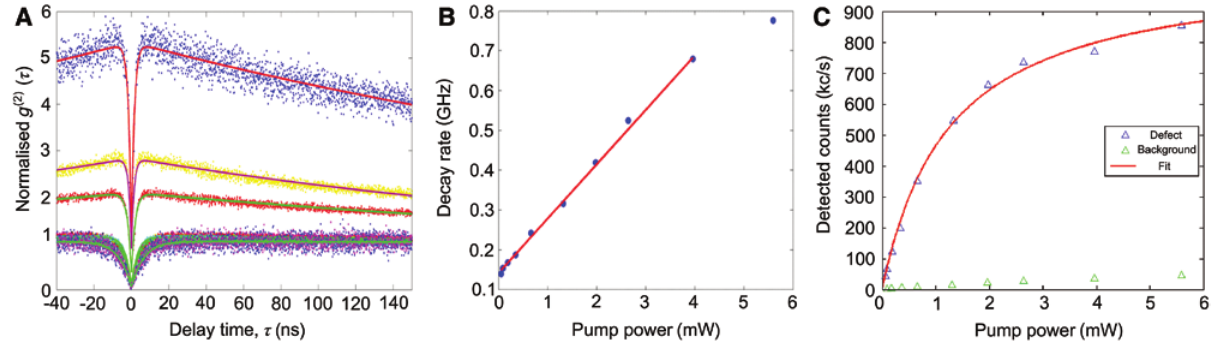
Figure 3: (A) Background-corrected g (2) histograms of the bright emitter in Figure 1B as a function of increasing pump power, which has been offset vertically. The range of pump powers is from 185 μ W to 5.56 mW with increasing bunching behaviour observed at the “shoul- ders” of the antibunching dip for higher pump powers. (B) Excited state decay rates for a three-level model fit of the bright emitter [19, 54]. The intrinsic excited state lifetime of the emitter is approximately 7 ns. Data were fitted with a linear fit to extract the lifetime for low powers using the intercept of the reciprocal lifetime. The single point at the highest pump power of 5.56 mW does not follow this linear trend and indicates that, at high incident powers, additional terms may need to be included in the model. (C) Saturation curve for a bright emitter found on the sample. The blue diamonds and green triangles represent signal from the defect (background subtracted) and background, respectively. The red line represents fit of the emission rate as a function of pump